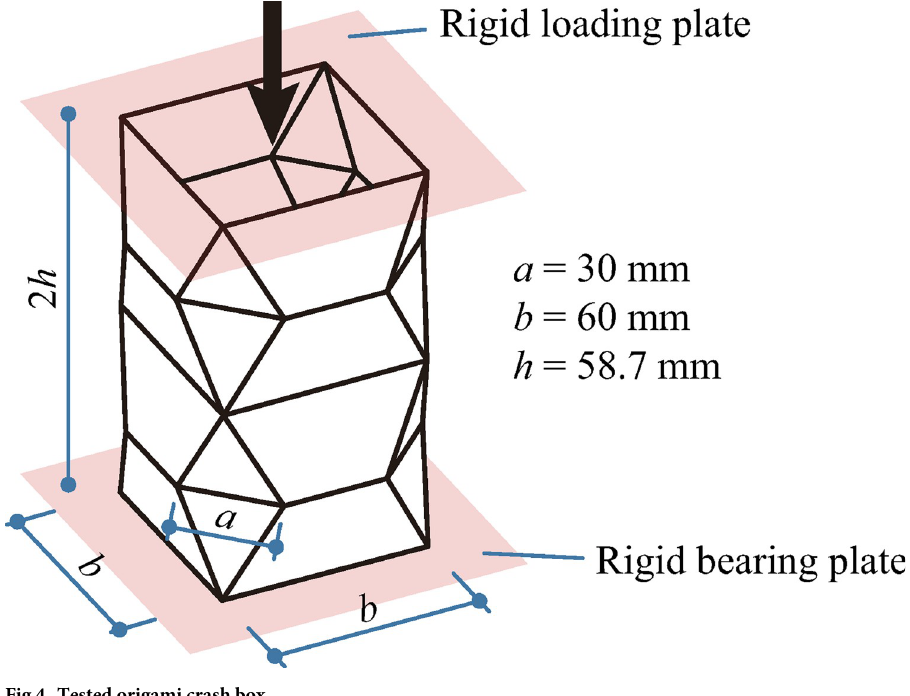
Fig 4. Tested origami crash box.